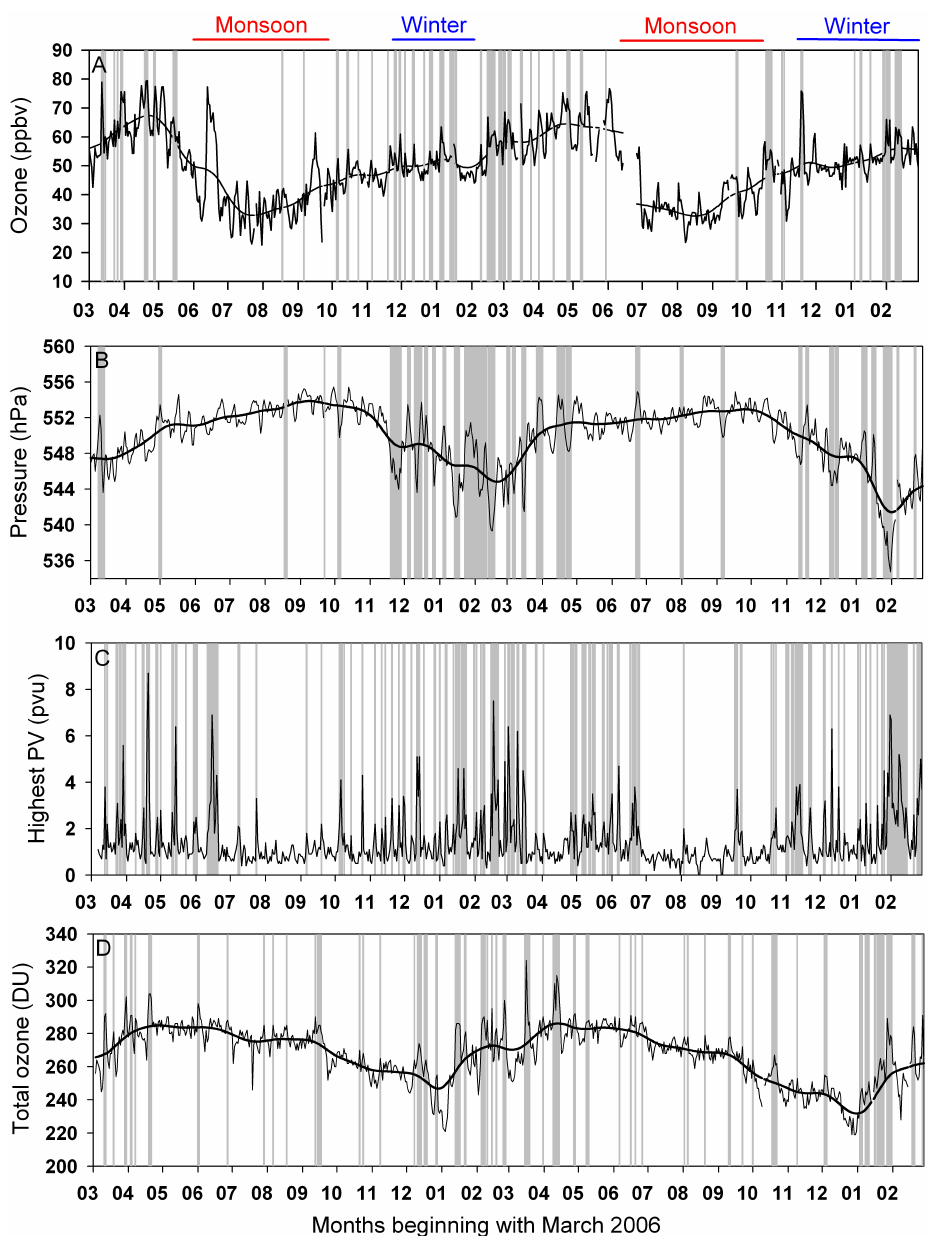
Fig. 2. Time series (daily average values) of surface O 3 (A) , atmospheric pressure (B) , maximum potential vorticity over 14 back-trajectories extending up to 50hPa over the measurement site altitude (C) and total column ozone (D) from March 2006 to February 2008. For surface O 3 , atmospheric pressure and total O 3 , the thick lines represent the seasonal behaviour obtained by applying the KZ filtering. The vertical grey bars denote the days characterised by parameter values exceeding the threshold for detection of SI events. Top horizontal coloured bars denote winter and monsoon